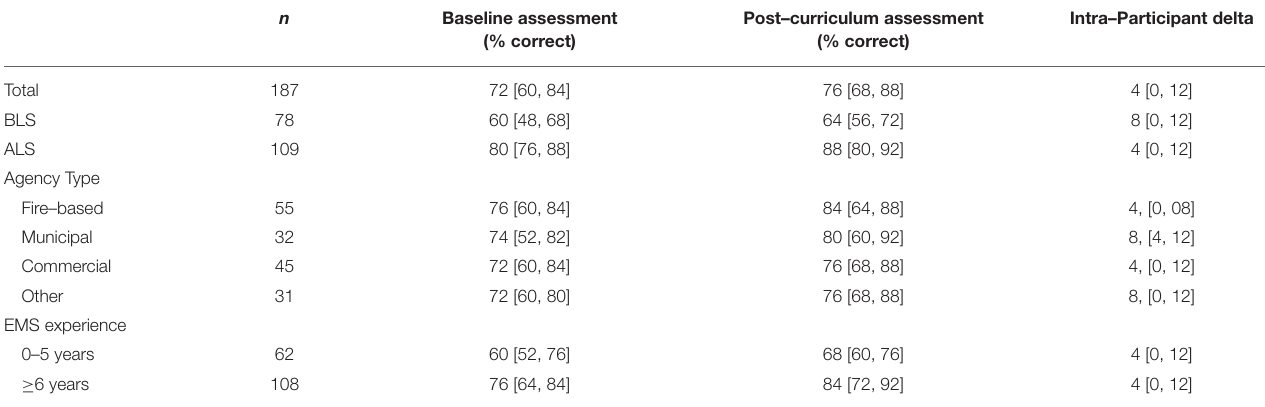
TABLE 2 | Knowledge assessment pre– and post–curriculum.